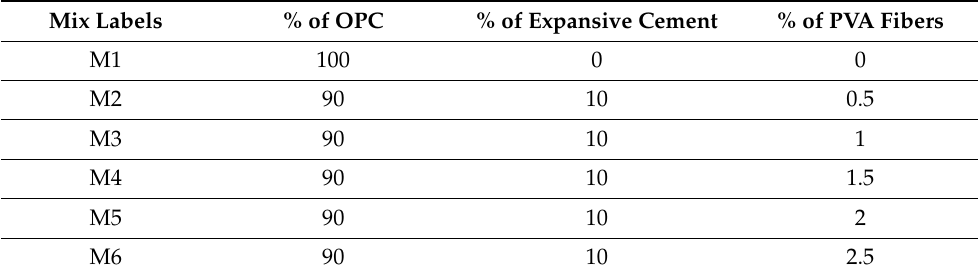
Table 2. The specifics of expansive cement concrete mixes with PVA fiber reinforcement. Mix Labels % of